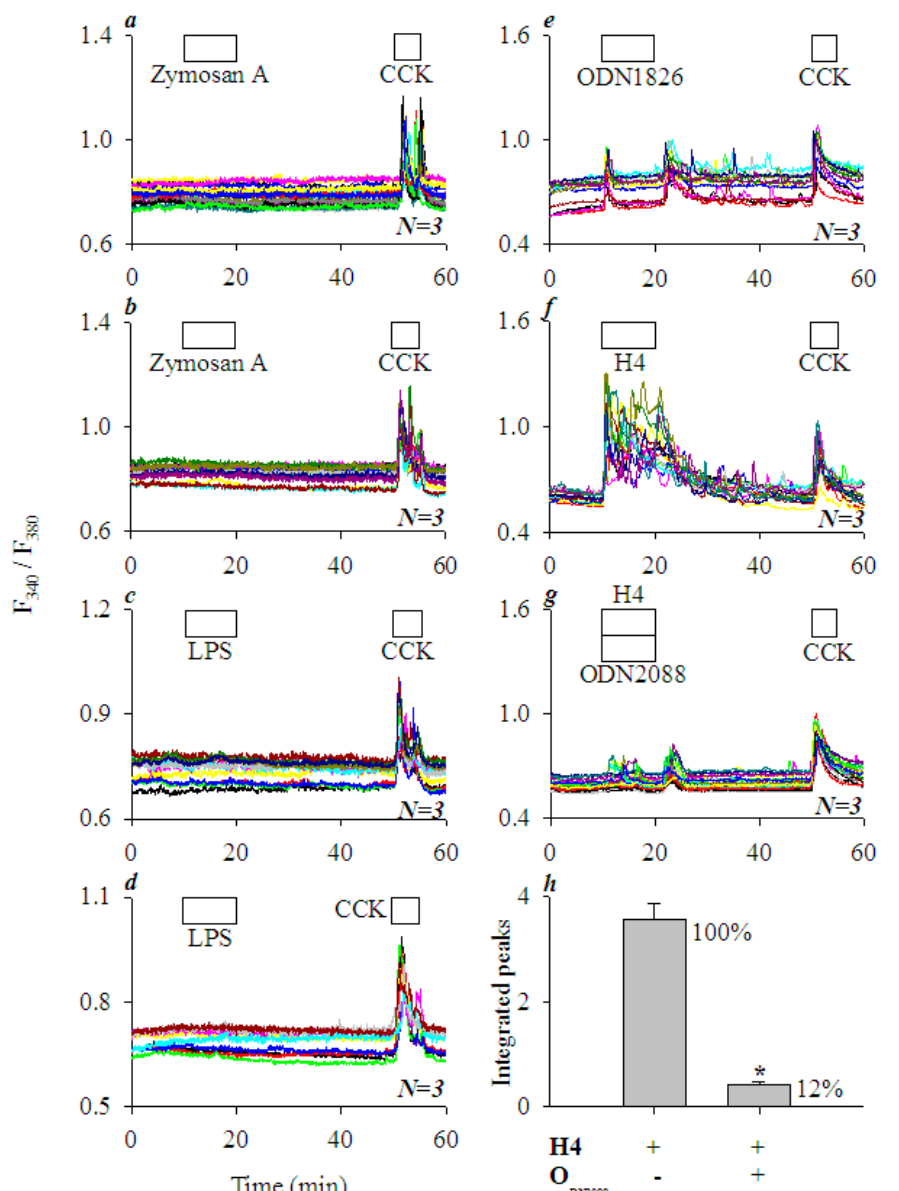
Figure 5. TLR2 and TLR4 agonists had little effect but TLR9 agonist elicited calcium oscillations; histone-induced calcium oscillations were blocked by TLR9 antagonist in AR4-2J cells. Fura-2-loaded AR4-2J were perifused; TLR2 agonist zymosan A, TLR4 agonist LPS, TLR9 agonist ODN1826, CCK, H4, or TLR9 antagonist ODN2088 were added as indicated by the horizontal bars. TLR2 agonist zymosan A (10, 100 mgL − 1 , a , b ), TLR4 agonist LPS (1, 10 mgL − 1 , c , d ) and TLR9 agonist ODN1826 (5 µ M, e ) were added before CCK (20 pM) ( a – e ). H4 (5 mgL − 1 , f ) alone or H4 (5 mgL − 1 ) plus TLR9 antagonist ODN2088 (5 µ M, g ) were added before CCK (20 pM, f , g ). Note that H4-induced calcium oscillations were blocked by simultaneous addition of TLR9 antagonist ODN2088 ( g ), as confirmed by statistical analysis (area under the peaks above the basal level, h ). The asterisk (*) in ( h ) indicates P < 0.05. The calcium traces shown in ( a – g ) are each representative of N identical experiments ( N =